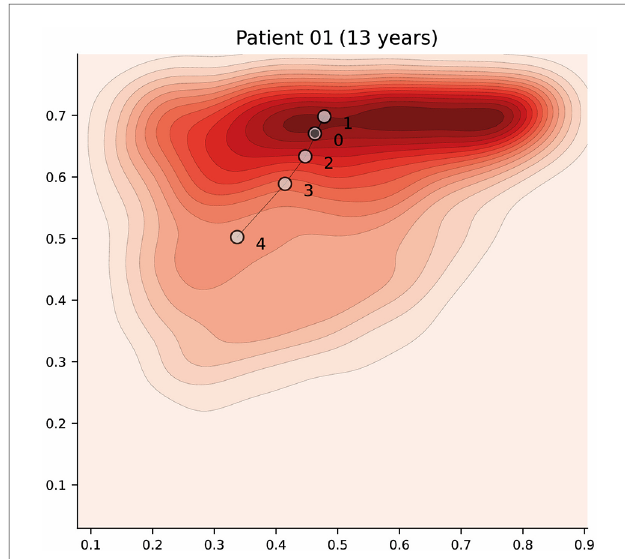
FIGURE 7 Latent space description: Trajectories. The graph represents the trajectory of a patient over the latent space using the density distribution for Category A , which associated with severe disease, as a background reference. Each marker represents a daily pro fi le where the number indicates the day from admission. Filled markers indicate days in which the patient suffered an episode of shock. Further examples have been included in Figure A3 (Appendix)